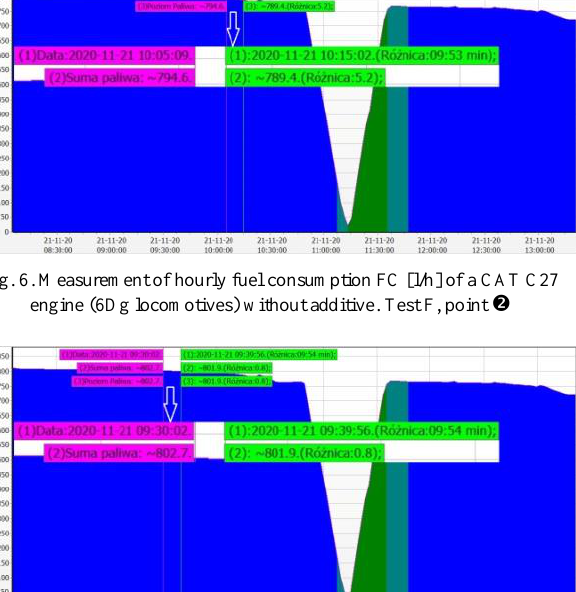
Fig. 2. General view of the water resistor